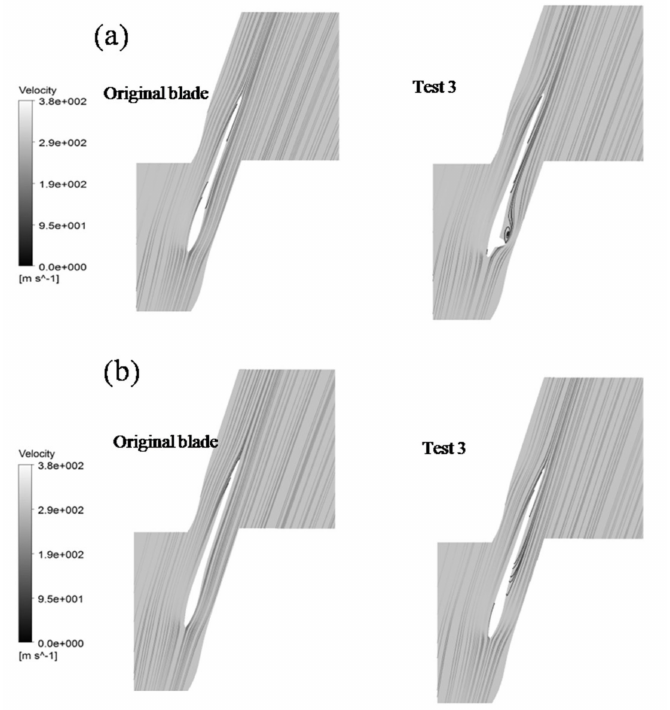
Figure 12. Surface streamlines distribution of the original blade (left) and test 3 (right) on ( a ) 89.5% and ( b ) 87.5% spanwise sections at case 2.